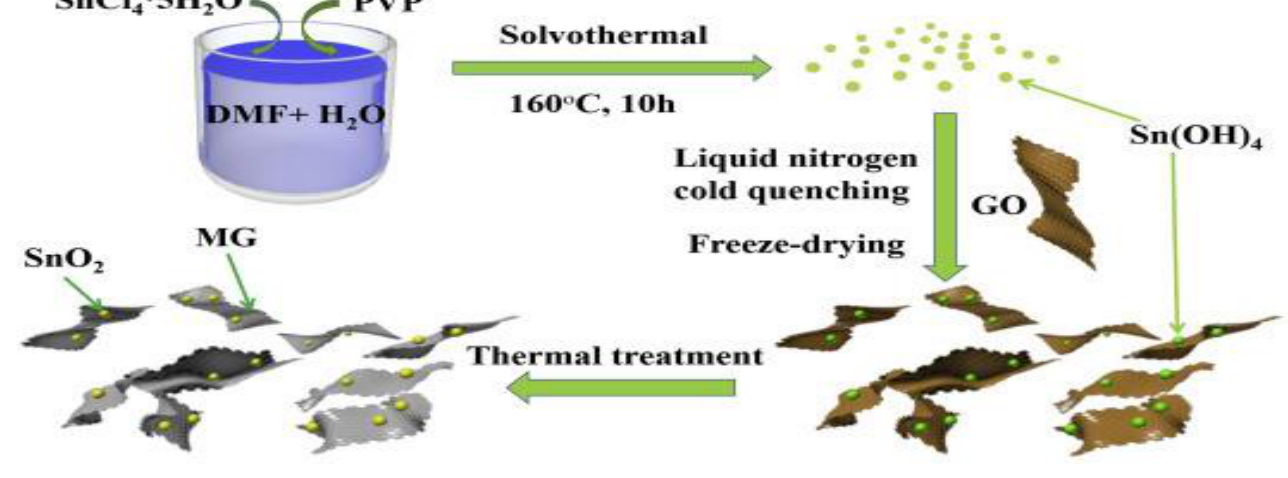
Figure 7. The synthesis process of SnO 2 /MG nanosheets. Reprinted with permission from [96]. Copyright 2019 Elsevier .